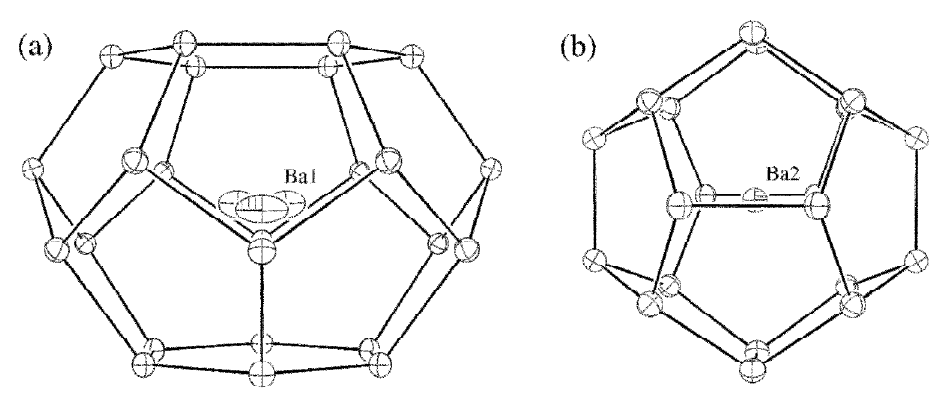
Figure 3. Representations with anisotropic displacement parameters of: ( a ) the Ba1 atom at tetrakaidecahedra); and ( b ) the Ba2 atom the 24 k site (off-set from center of the (Ga,Sn) 24 at the 2 a site (center of the (Ga,Sn) pentagonal dodecahedra). Thermal ellipsoids are 20 drawn at the 95% probability